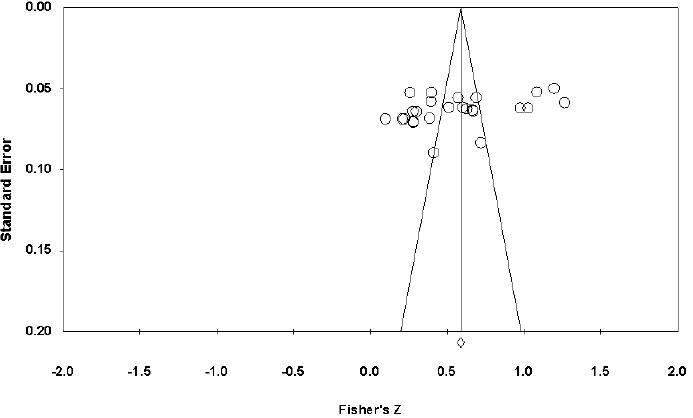
Figure 4. Funnel Diagram of Green Resource Absorption and Integration.